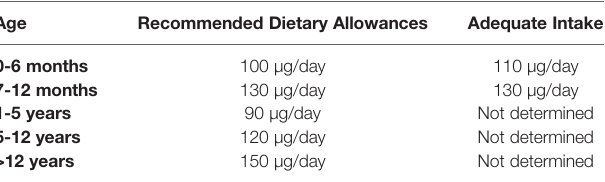
TABLE 2 | Reference of iodine values by age, according to Institute of Medicine recommendation (29, 40, 41). Age Recommended Dietary Allowances